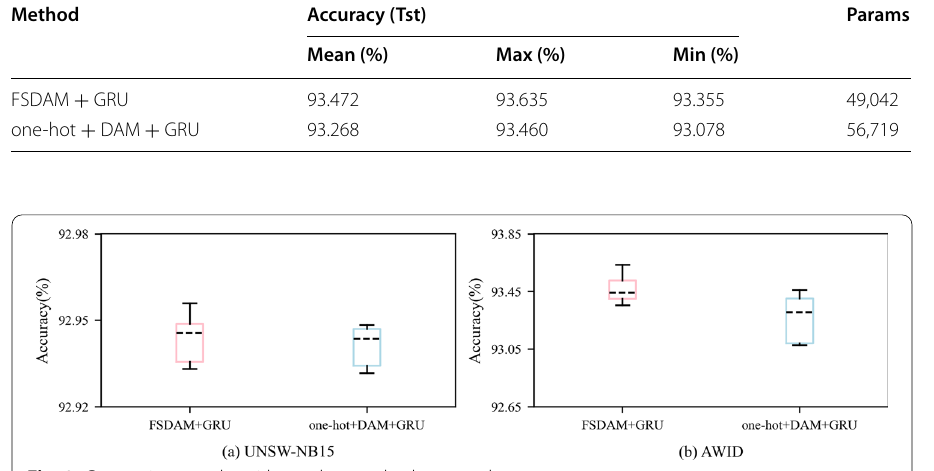
Table 10 Accuracy and parameters of different methods on AWID Method